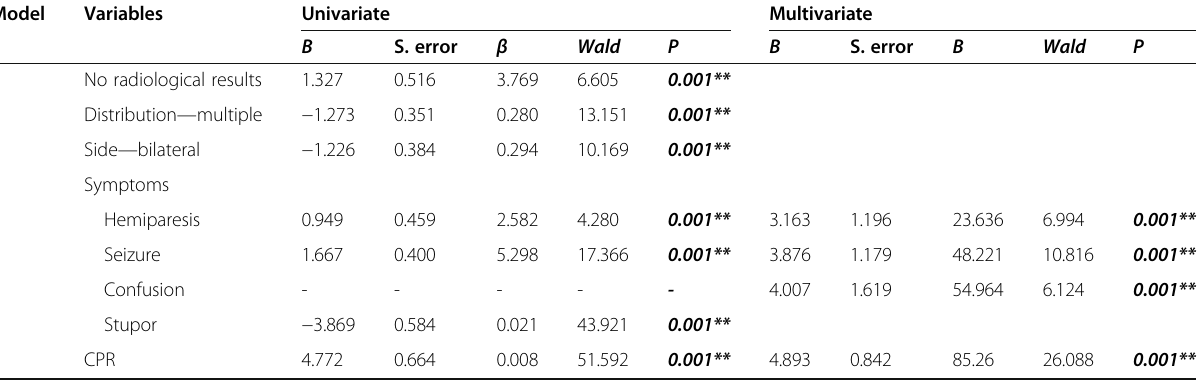
Table 5 Logistic regression analysis results for prediction of life status with independent variables